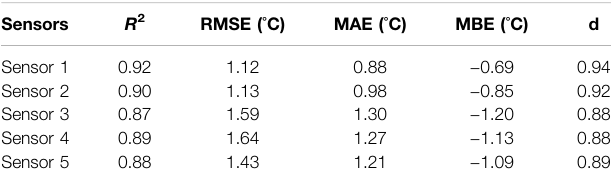
( Figure 1 ) (Salvati and Kolokotroni, 2019). Air temperature and relative humidity were obtained from monitoring sensors, HOBO MX2301, ONSET, with the measurement accuracy of ±0.2 ° C for air temperature and ±2.5% for relative humidity.